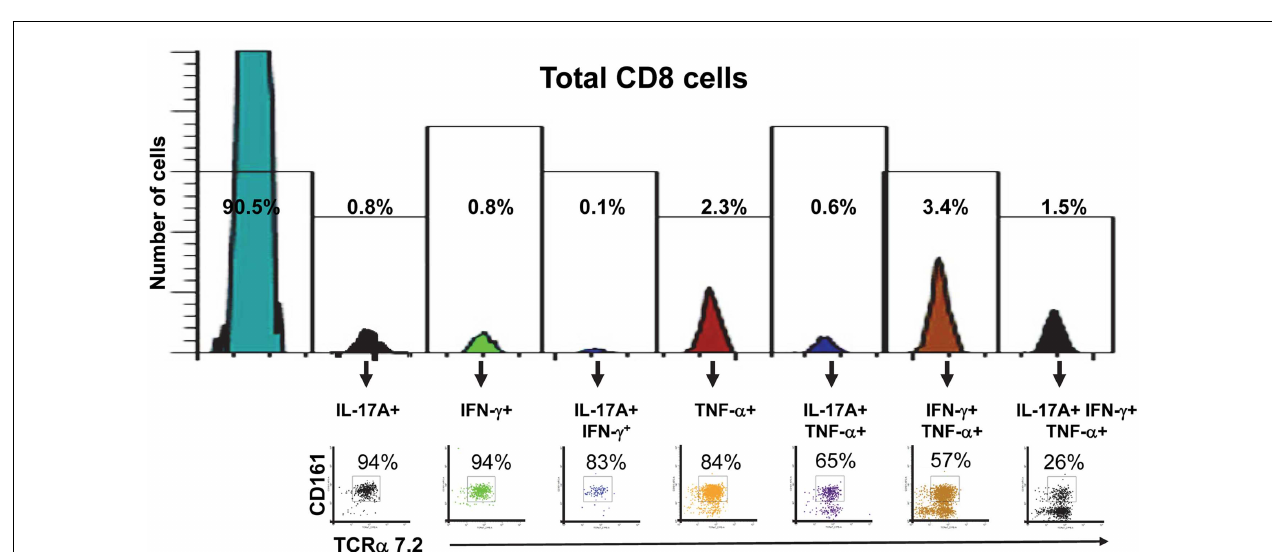
dead cells (ViViD + ) as well as macrophages/monocytes (CD14 + ), B lymphocytes (CD19 + ), and targets (CD45 + ) from analysis.This was followed by additional gating on CD3 and CD8 to identify multi-functional CD8 + cells. Subsequent gates onTCR α 7.2 and CD161 were used to identify MAIT cells among each of the seven defined sub-phenotypes of CD8 + cells.The data is representative of one experiment showing mono-functional or multi-functional MAIT cell responses to B-LCL cells infected with E. coli strain HS at a multiplicity of infection (MOI) of 1:200. Data are representative of five